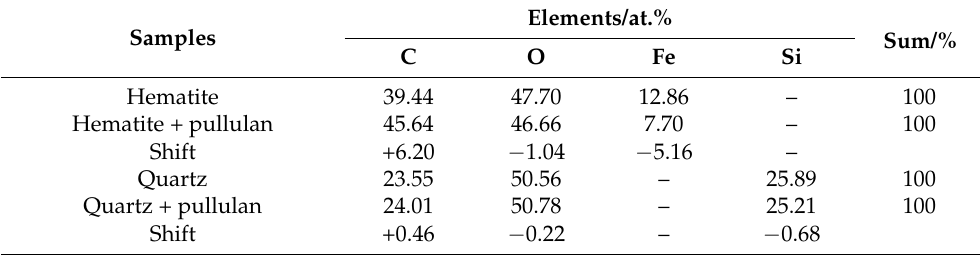
Table 2. The changes of surface elements in hematite and quartz before and after pullulan treatment. Samples